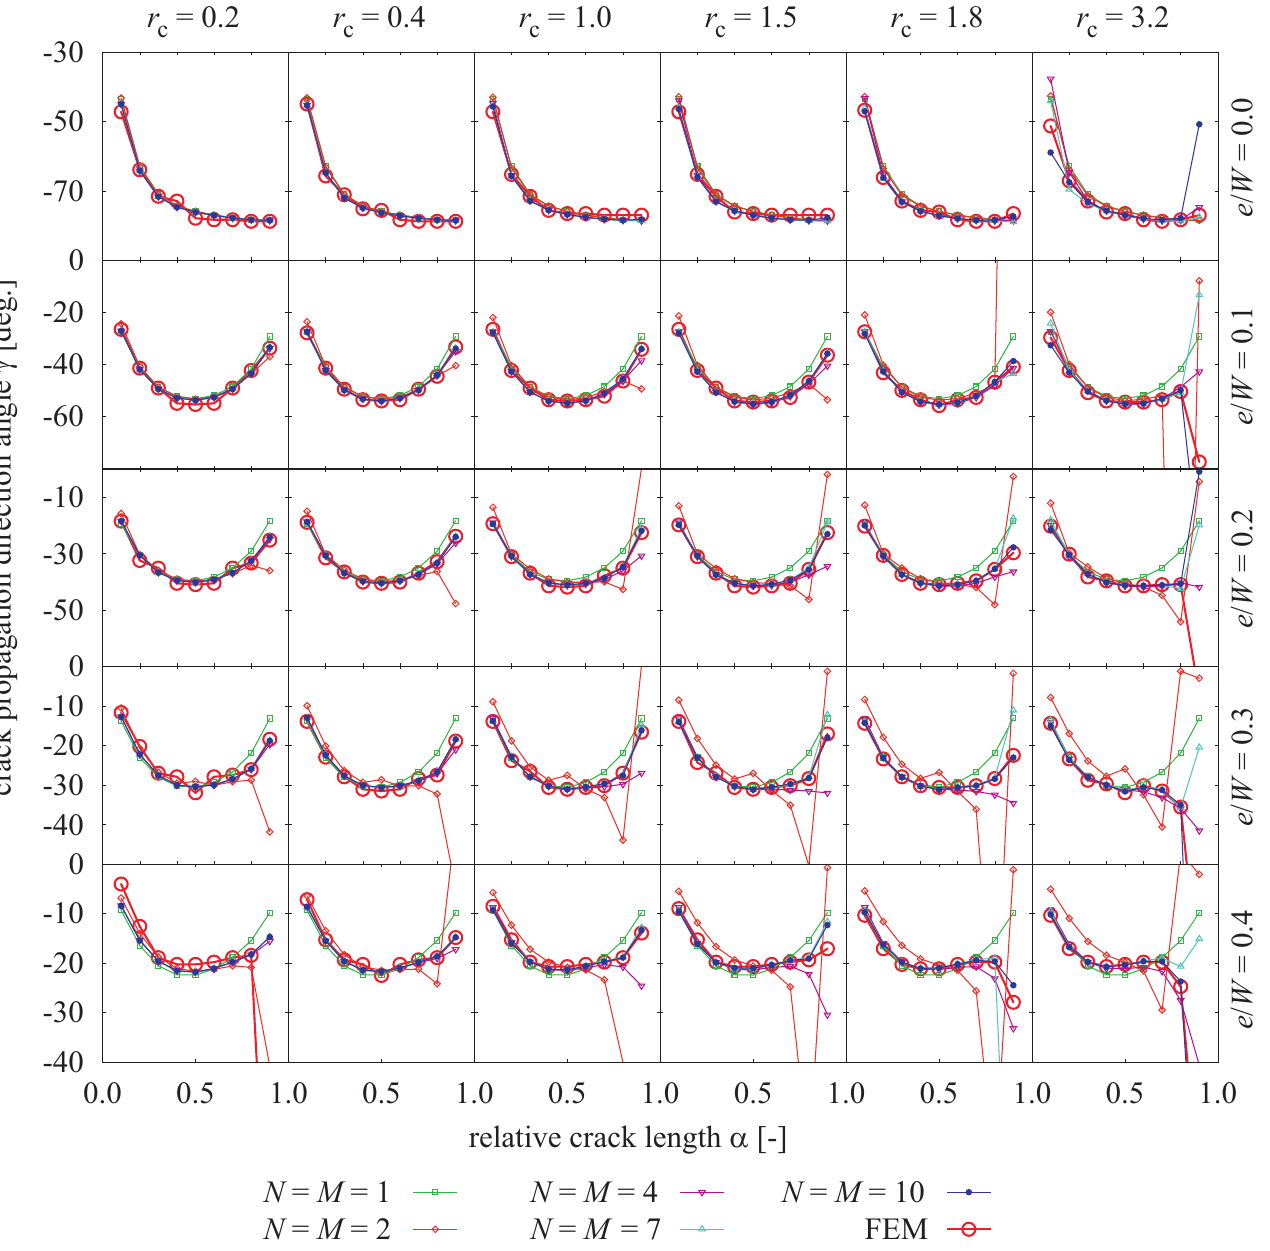
Figure 3: Dependences of the initial crack propagation direction angle γ on the relative crack length  for various relative crack eccentricities e / W obtained from the SED fracture criterion at various radial distances from the crack tip r c ; the purely numerical results ("FEM") are compared to the semi-analytical results (" N = M = 1, 2, 4, 7 and 10") calculated via the multi-parameter form of the fracture